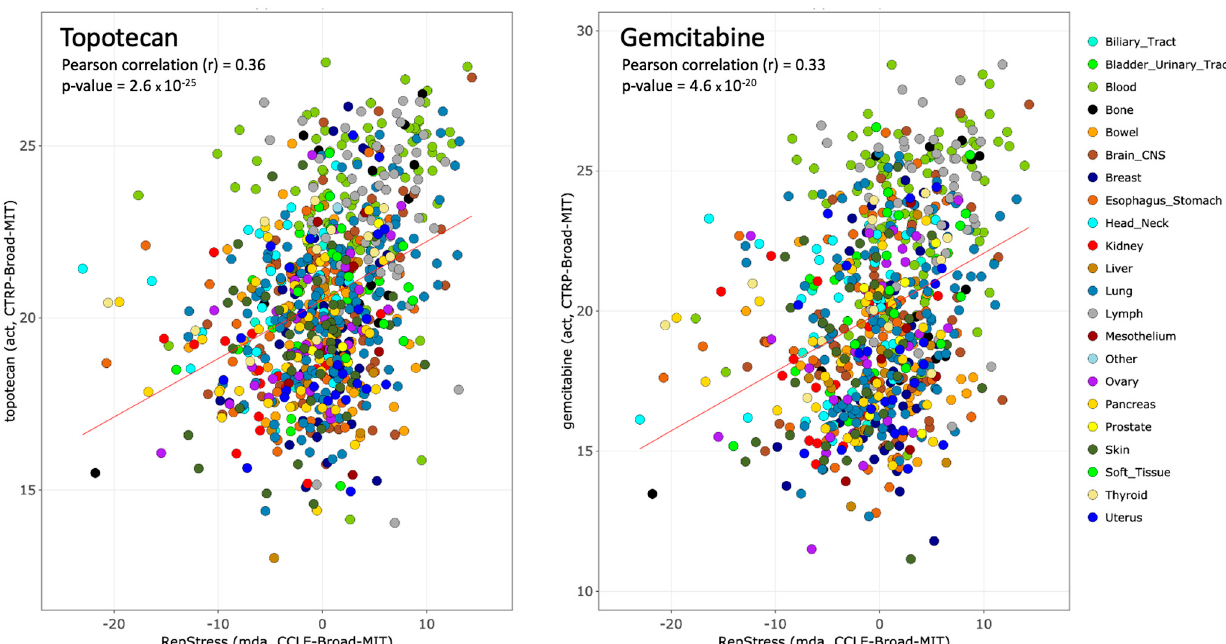
Figure 4. Predictive value of the RepStress genomic signature in the CCLE ‐ CTRP Broad Institute cancer cell line databases for the TOP1 inhibitor topotecan ( left ) and the replication inhibitor gemcitabine ( right ). Data were generated from CellMinerCDB (https://discover.nci.nih.gov/cellminercdb/ (9 February 2021)).